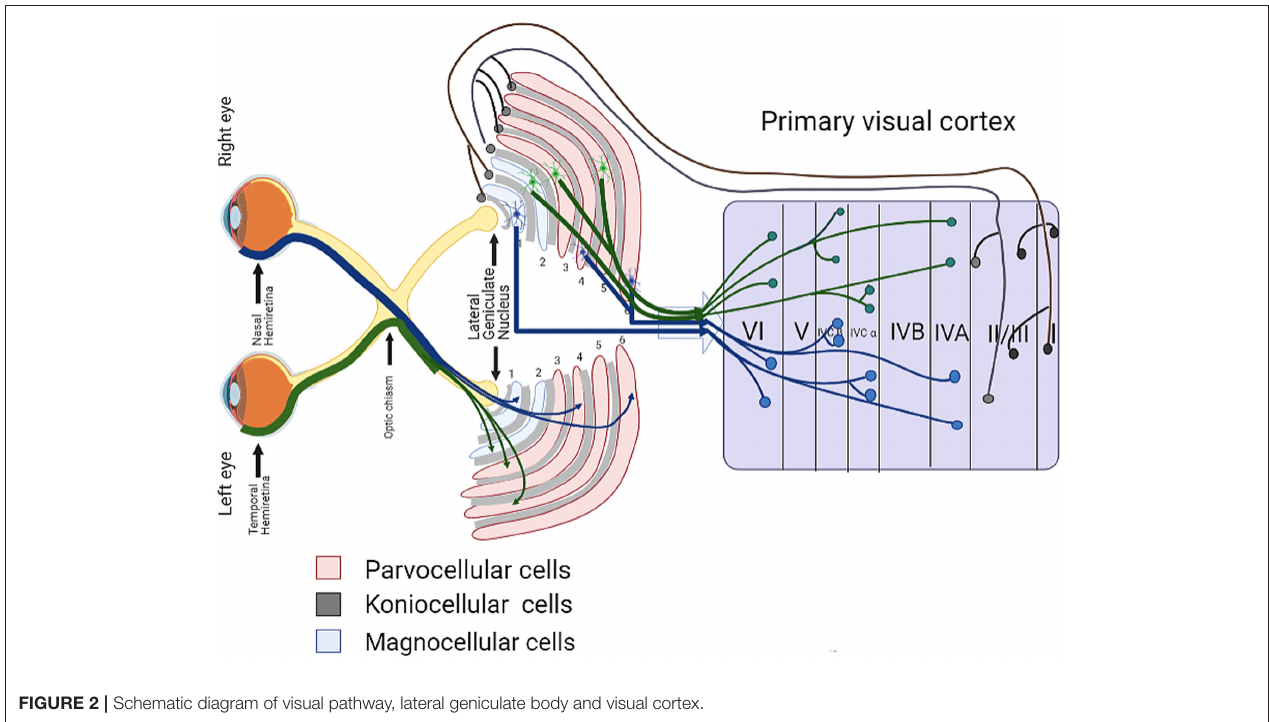
FIGURE 2 | Schematic diagram of visual pathway, lateral geniculate body and visual cortex.